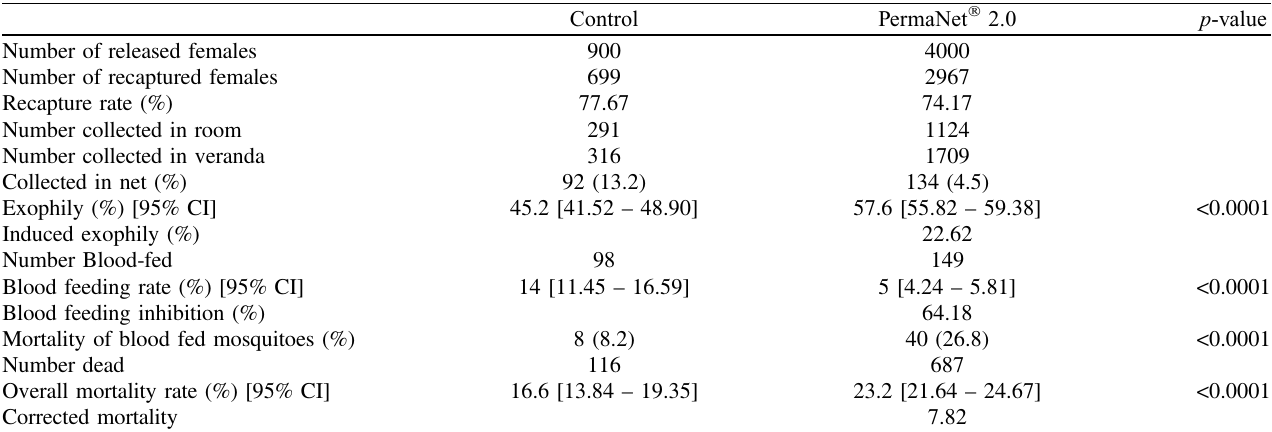
Table 4. Evaluation of behavioural response of resistant Anopheles gambiae s.l. population exposed to PermaNet (cid:1) 2.0 nets.